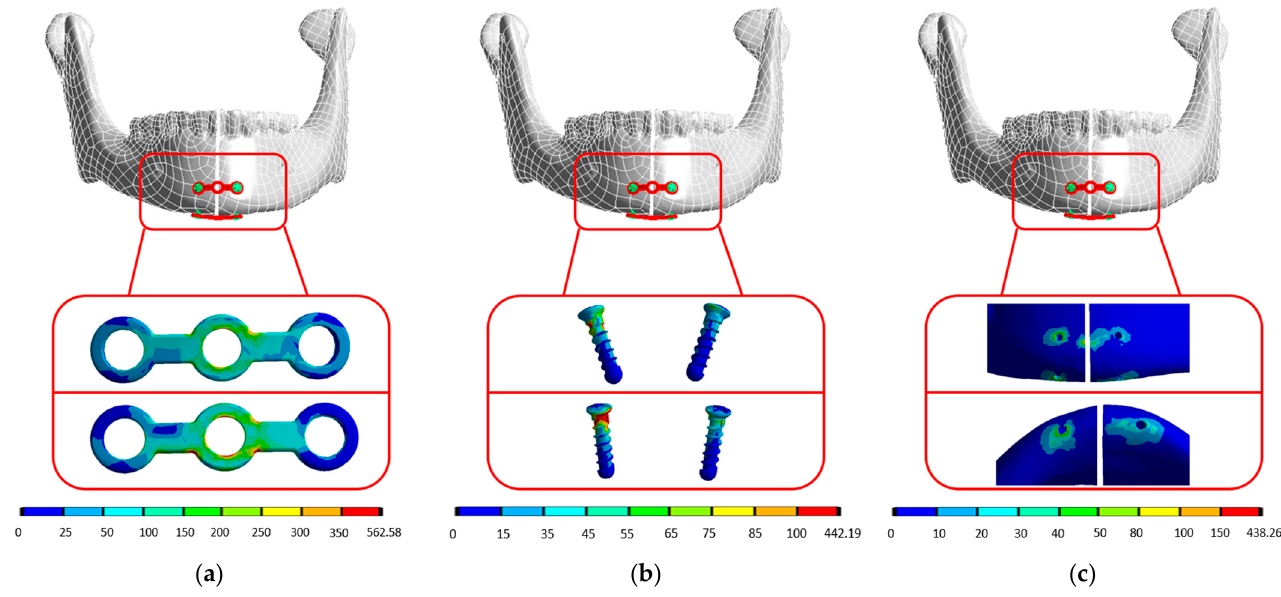
Figure 4. Stress distribution of PerD2HP. ( a ) plate; ( b ) screws; ( c ) screw holes. (Unit: MPa).